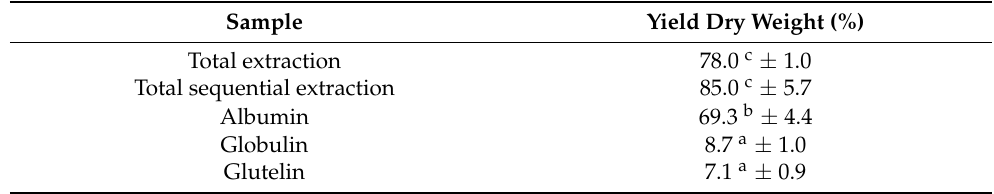
Table 2. Protein extraction yield for total and sequential process